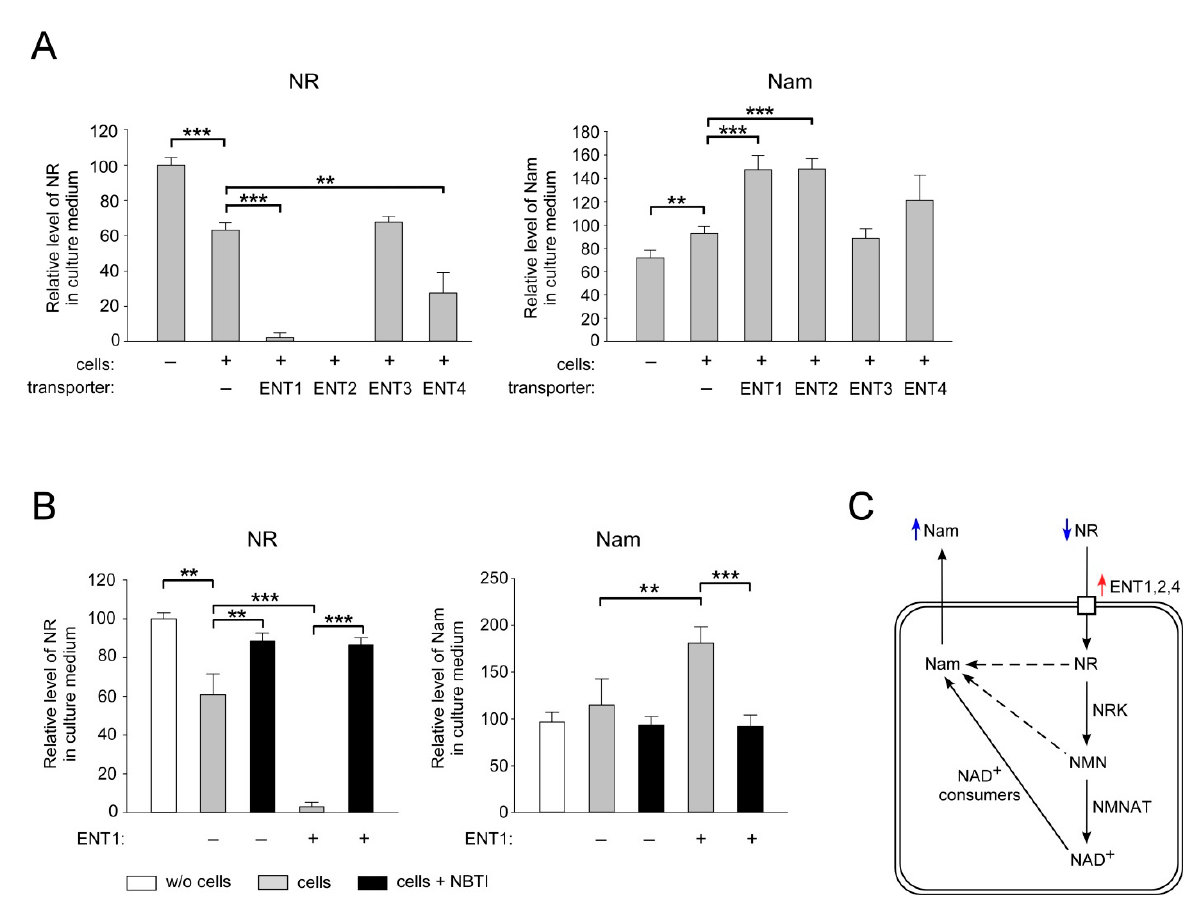
Figure 2. Overexpression of ENT1, ENT2 and ENT4 stimulates NR uptake into HEK293 cells. ( A , B ) HEK293 cells cultivated in DMEM were transiently transfected with empty vector or with vectors encoding FLAG-tagged ENT1, 2, 3, or 4 as indicated. Twenty-four hours after transfection, cells were treated with NR (100 µM). In ( B ), cells were additionally treated with NBTI (10 µM) as indicated. Twenty-four hours after treatment, culture medium was analyzed by NMR spectroscopy. Relative levels of NR and Nam in culture medium are presented. The amount of NR in control culture media incubated without cells was taken as 100. Data are presented as mean ± S.D ( n = 3). Statistical analysis of differences between the groups was carried out by one-way ANOVA with post hoc comparisons using Tukey test. ** indicates statistical significance at p < 0.01, *** indicates statistical significance at p < 0.001. ( C ) Schematic interpretation of the results shown in ( A , B ). Blue arrows: changes in extracellular metabolite concentrations; red arrow: overexpression of FLAG-tagged proteins.